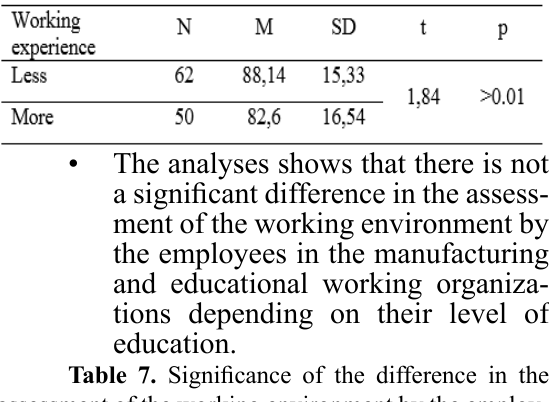
Table 6. Significance of the difference in the personal sense for communication between the employ - ees in the manufacturing and educational working orga - nizations, as far as working experience is concerned